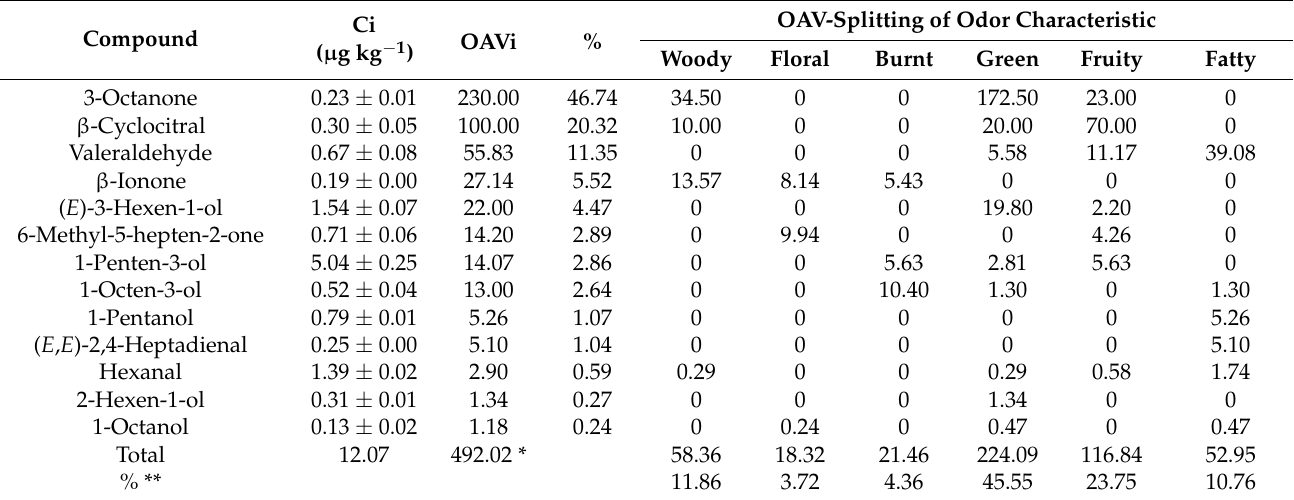
Table 2. The content, OAVi and OAV-splitting of key aroma compounds in green